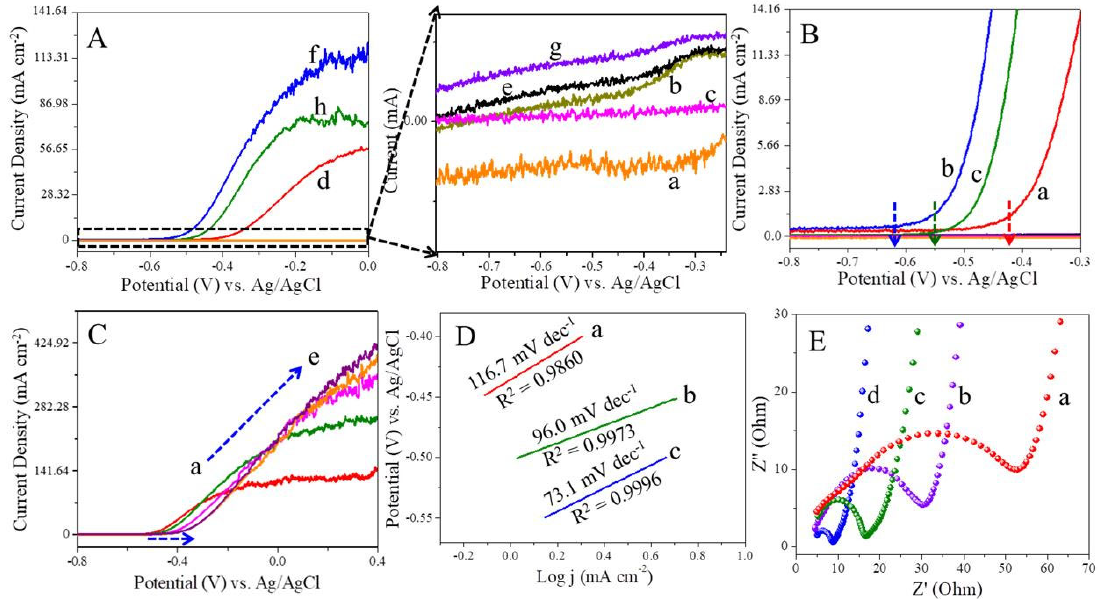
Figure 5. ( A ) LSV polarization curves obtained for bare GCE in the absence (curve a), and presence of 0.10 M hydrazine (curve b); The GCE modified with NCNTs, Co@NCNTs − 1, and Co@NCNTs − 2 catalysts in the absence (curves c, e, and g), and the presence of 0.10 M hydrazine (curves d, f, and h) in 1.0 M NaOH solution at a scan rate of 10 mV s − 1 . ( B ) NCNTs (curve a), Co@NCNTs − 1 (curve b), and Co@NCNTs − 2 (curve c) modified GCEs showing exact “onset” polarization curves of hydrazine electro-oxidation. ( C ) LSV polarization curves obtained at Co@NCNTs − 1 electrode in 1.0 M (a), 2.0 M (b), 3.0 (c), 4.0 (d), and 5.0 M (e) NaOH solution containing 0.1 M hydrazine at a scan rate of 10 mV s − 1 . ( D ) Tafel plots taken on a NCNTs (curve a), Co@NCNTs − 2 (curve b), and Co@NCNTs − 1 (curve c) catalyst samples modified GCEs resulting from their respective LSV curves. ( E ) EIS responses obtained at bare GCE (curve a), NCNTs (curve b), Co@NCNTs − 2 (curve c), and Co@NCNTs − 1 (curve d) catalyst-modified GCEs in 1.0 M NaOH + 0.10 M hydrazine